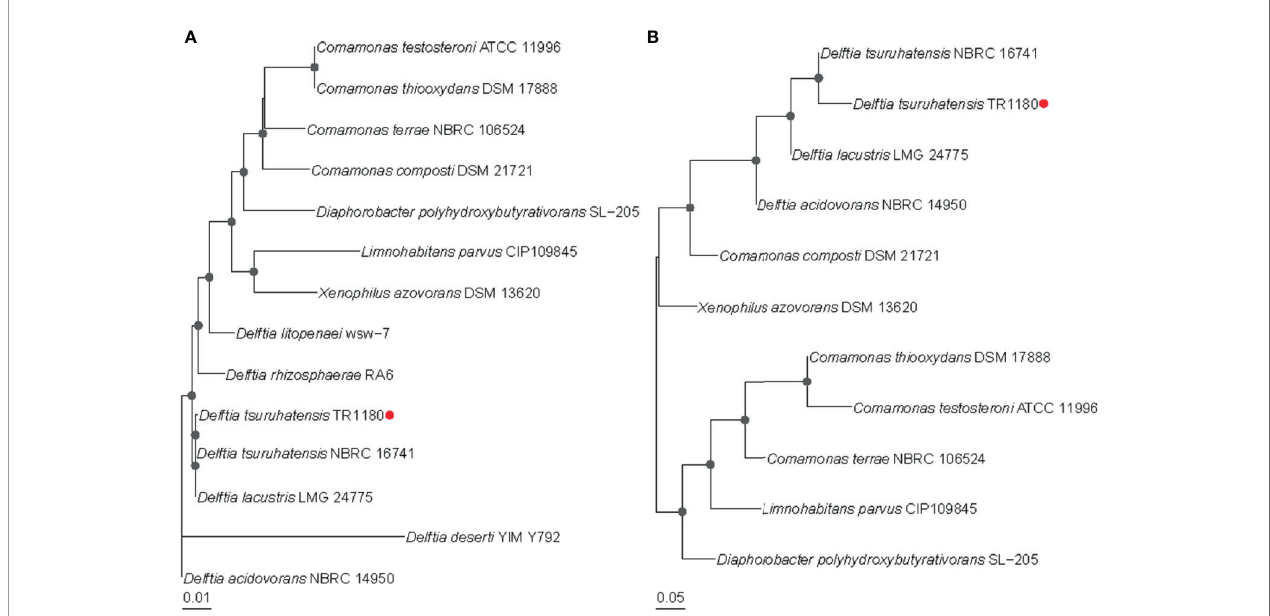
FIGURE 1 | Phylogenetic relationships of D. tsuruhatensis TR1180 with other type strains of Delftia species and genera within the family Comamonadaceae . Phylogenetic trees were based on (A) 16S RNA gene sequences and (B) whole-genome sequences. Bootstrap values greater than 50% are indicated by gray dots at the nodes. D. tsuruhatensis TR1180 is highlighted with a red dot.